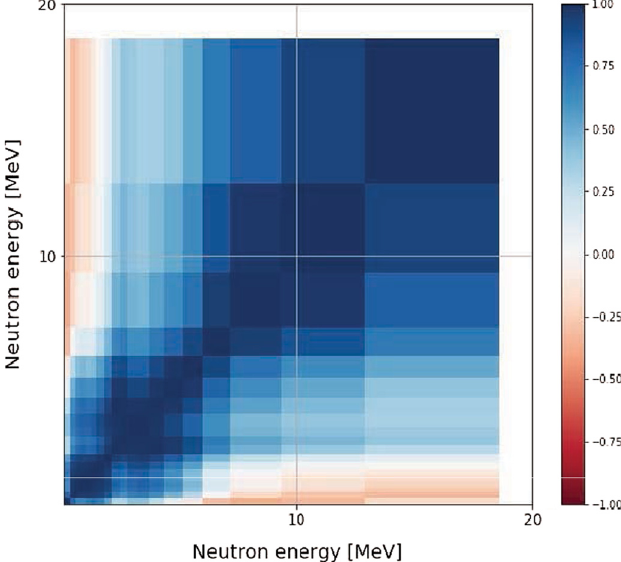
Fig. 6. Correlation matrix obtained for the (n,xn g ) cross section of the 111 keV g -transition in 184 W.